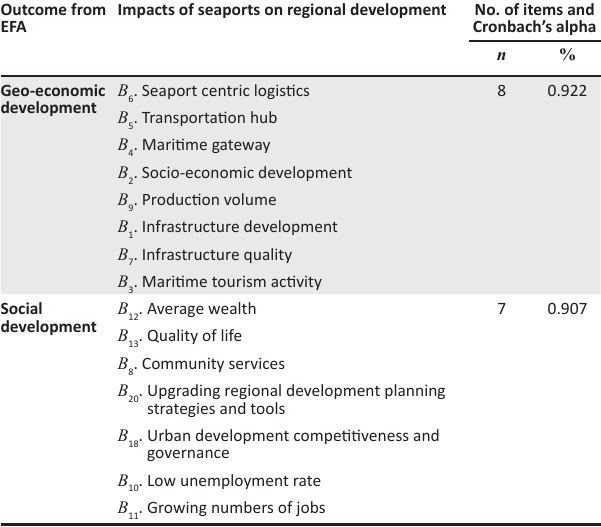
TABLE 3: Reliability test on the exploratory factor analysis results (Section B). Outcome from EFA